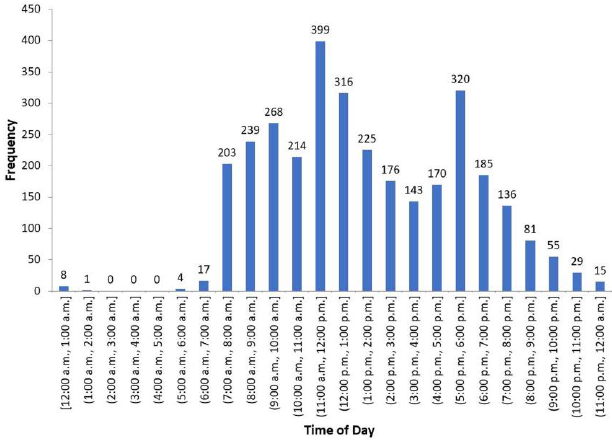
Figure 7. Histogram of charging events by time of day.